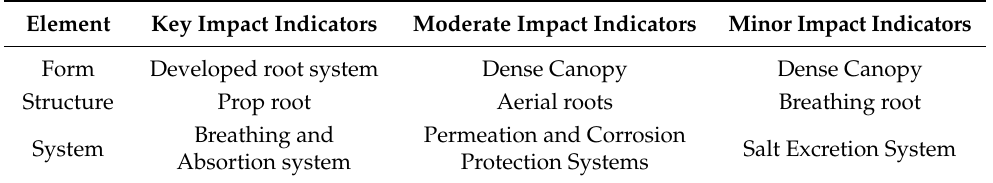
Table 3. The index and description of mangrove bionic design. Element Key Impact Indicators Moderate Impact Indicators